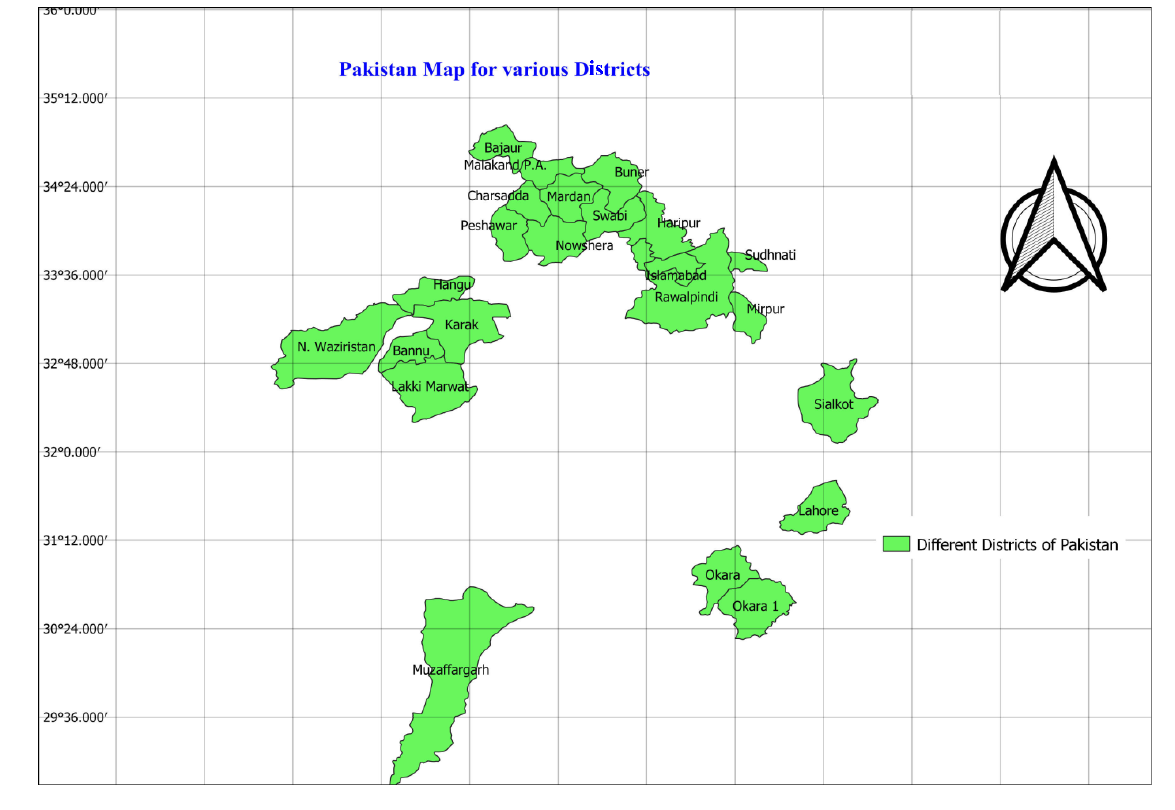
Figure 2. Location map of the soil study area.